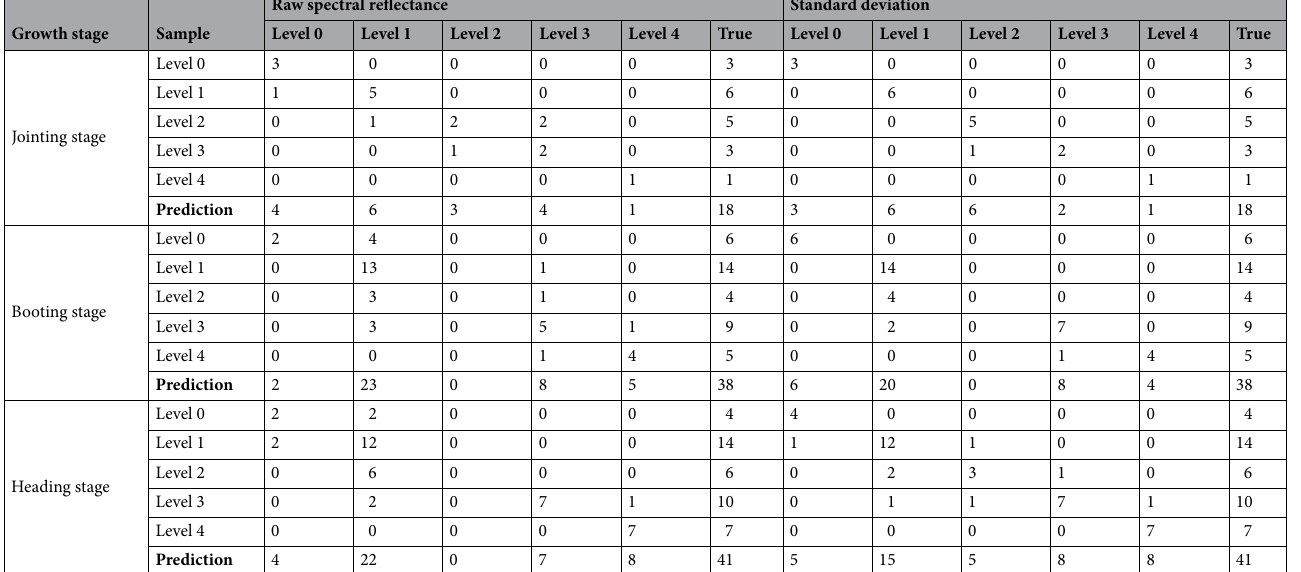
Table 2. Performances of the SVM models at different growth stages.